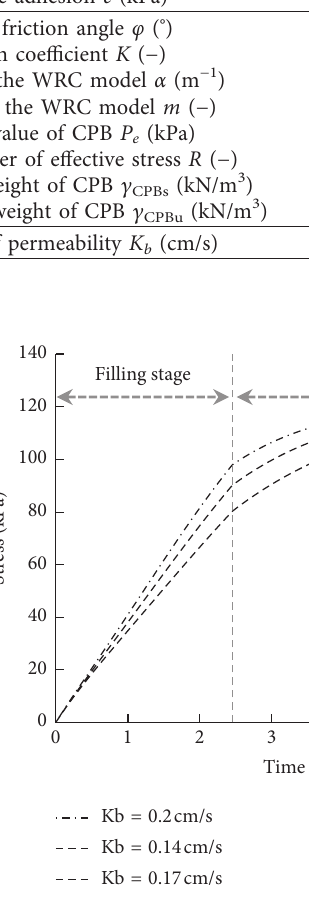
Figure 4: Variation of effective stress in CPB with different co- efficient of permeability of